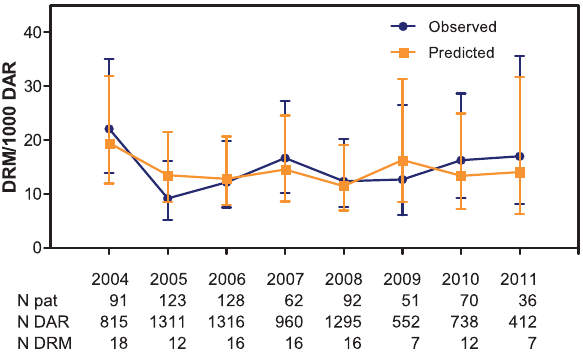
Figure 3. Observed and predicted group-level infection rates using updated model, per 1000 days at risk with 95% confidence intervals. Abbreviations: DRM – drain-related meningitis, DAR – days at risk, N pat – number of patients, N DAR – number of days at risk, N DRM – number of cases of drain-related meningitis.